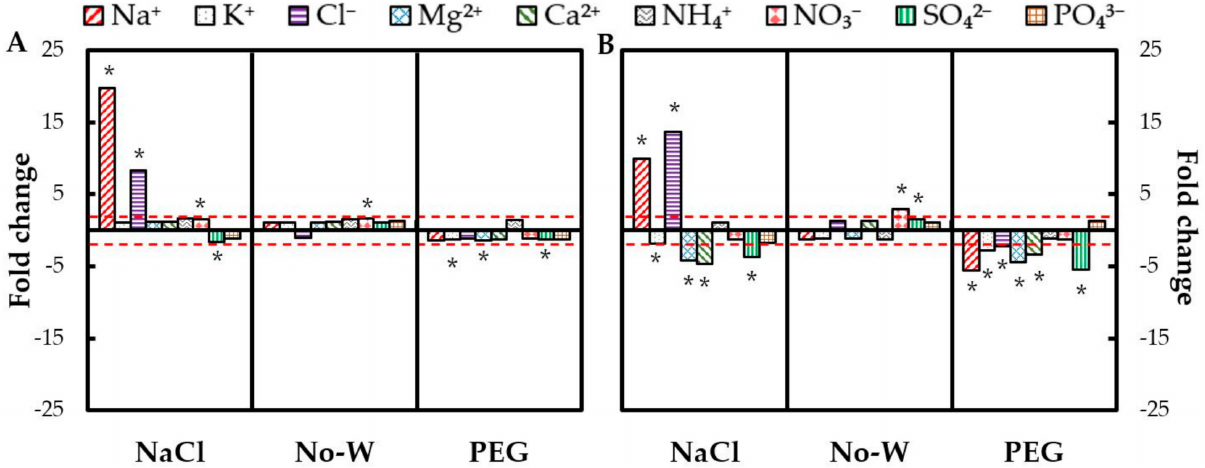
Figure 1. Representation of the inorganic ion content response to water-deficit stress. Bars represent the means ( n = 5) of the treatment/control ratios fold change in leaves ( A ) and roots ( B ). Asterisks represent statistical differences (Student’s t -test, p < 0.05) between control and treatments. No-W,